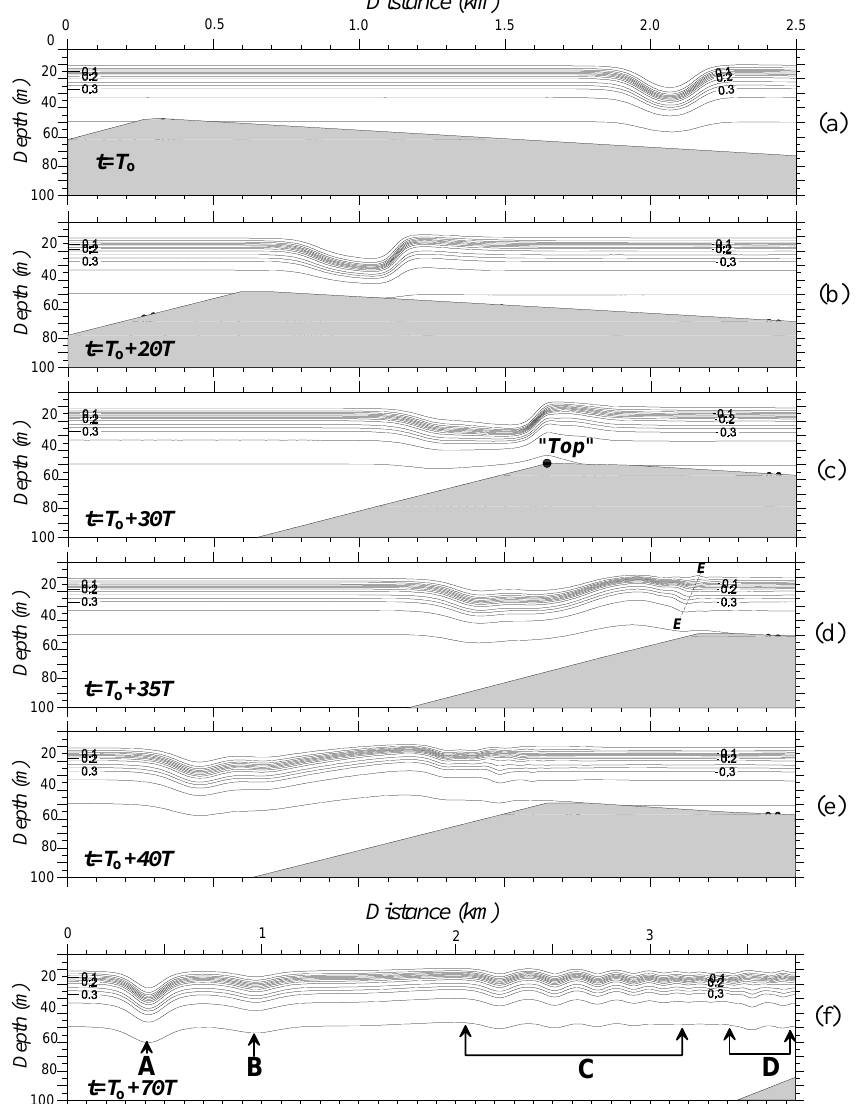
Fig. 5. Evolution of the density field in autumn (stratification 2 in Fig. 3) over the underwater ridge (along the cross section 2 in Fig. 1). The amplitude of the incoming wave is a m = 15m. The density anomaly relative to the free surface is shown. The contour interval equals 0.2 kg · m − 3 , the time scale T equals 365s. The leading solitary waves of depression are marked in panel (f) by the letters A and B, the secondary attached dispersive wave tail is shown by the segment C, the second mode internal waves by the segment D. Section E - E represents the initial stage of generation of second mode internal